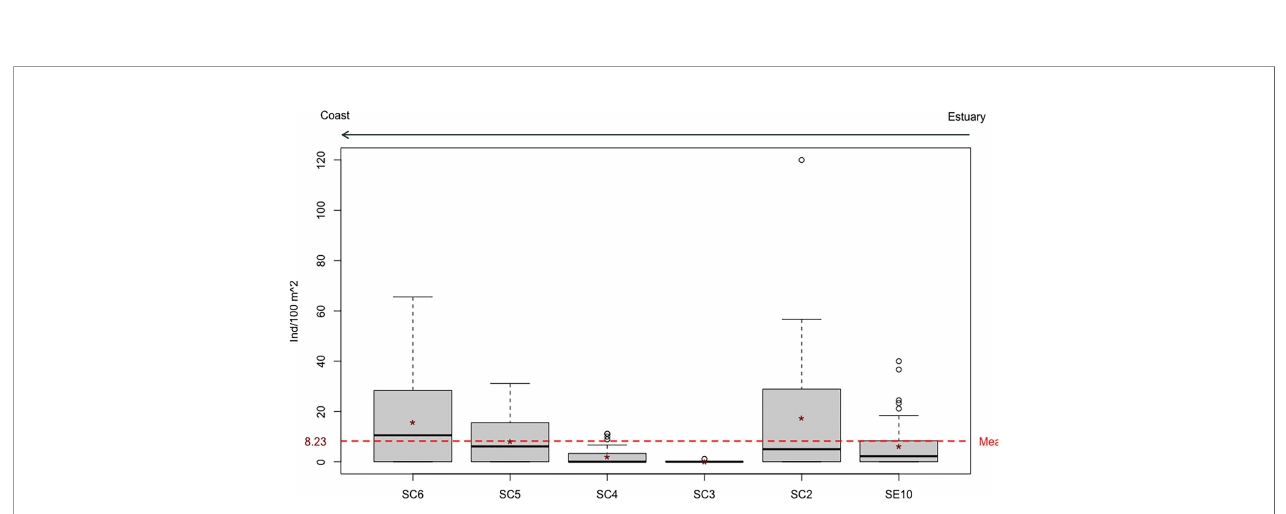
FIGURE 3 | Temporal density data for Holothuria mammata at Arra ́ bida, Setu ́ bal, during the nine month sampling period. Red dots at each month connected by a line represent the evolution of